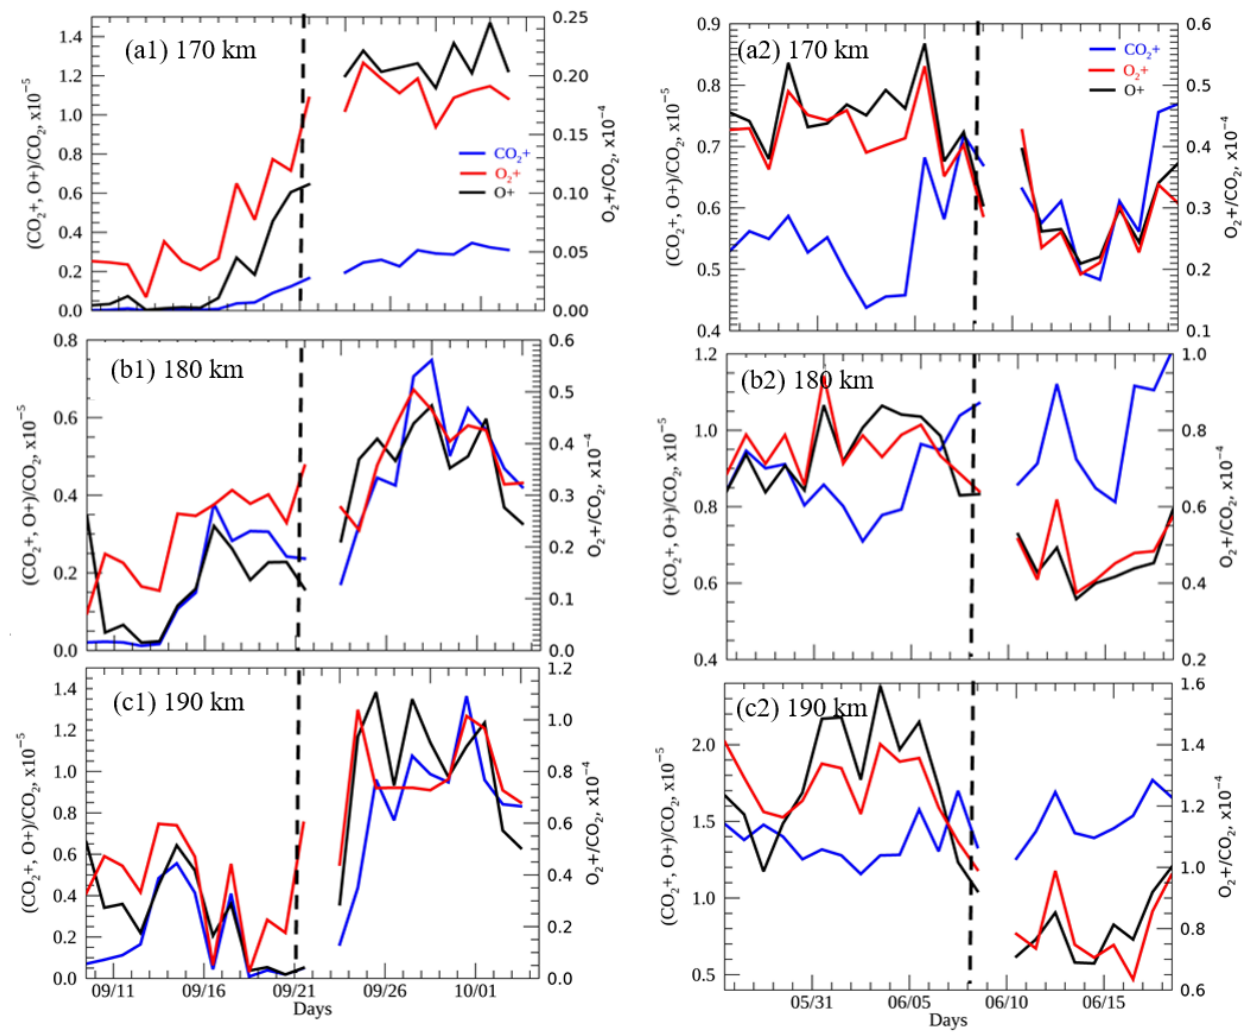
Figure 8. Ratio of (O 2+ , CO 2+ , and O + ) to CO 2 at 170, 180, and 190 km ( a1 – c1 ) from 9 September–2 indicates the storm onset. Left axis: CO 2+ and O + to CO 2 ; right axis: O 2+ to CO 2 . Table 1. Maximum and minimum ratios of O 2+ , CO 2+ , O + to CO and CO 2 from 9 Sep tember–2 Oct o-